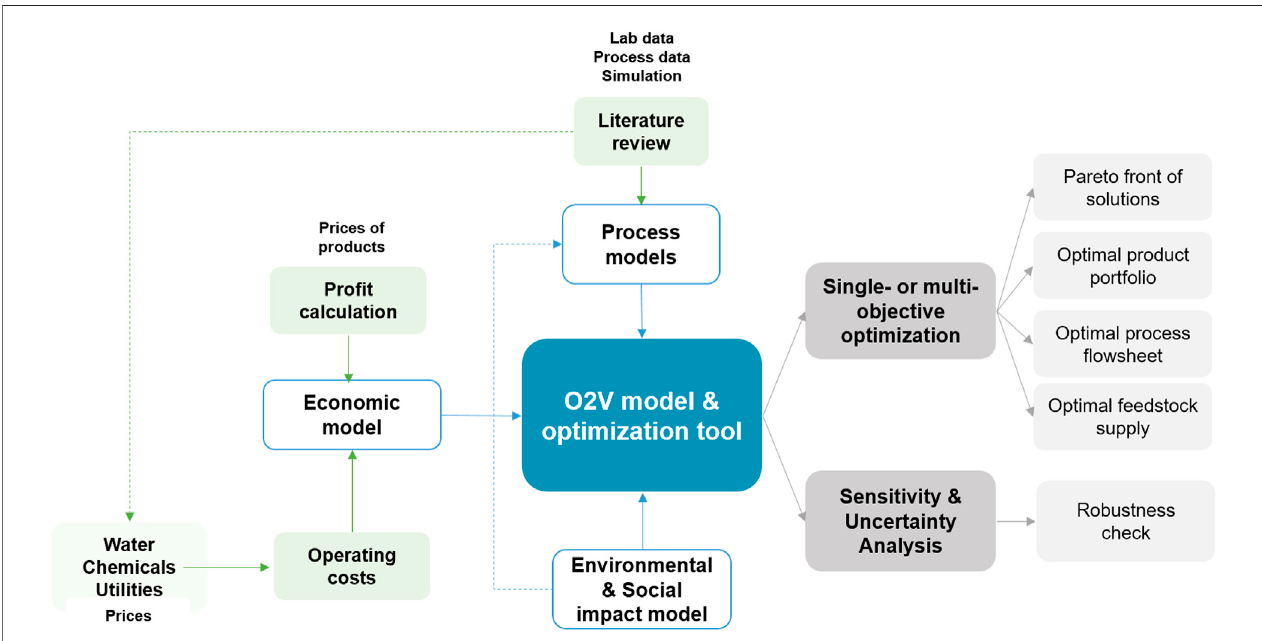
FIGURE 5 | O2V model inputs and